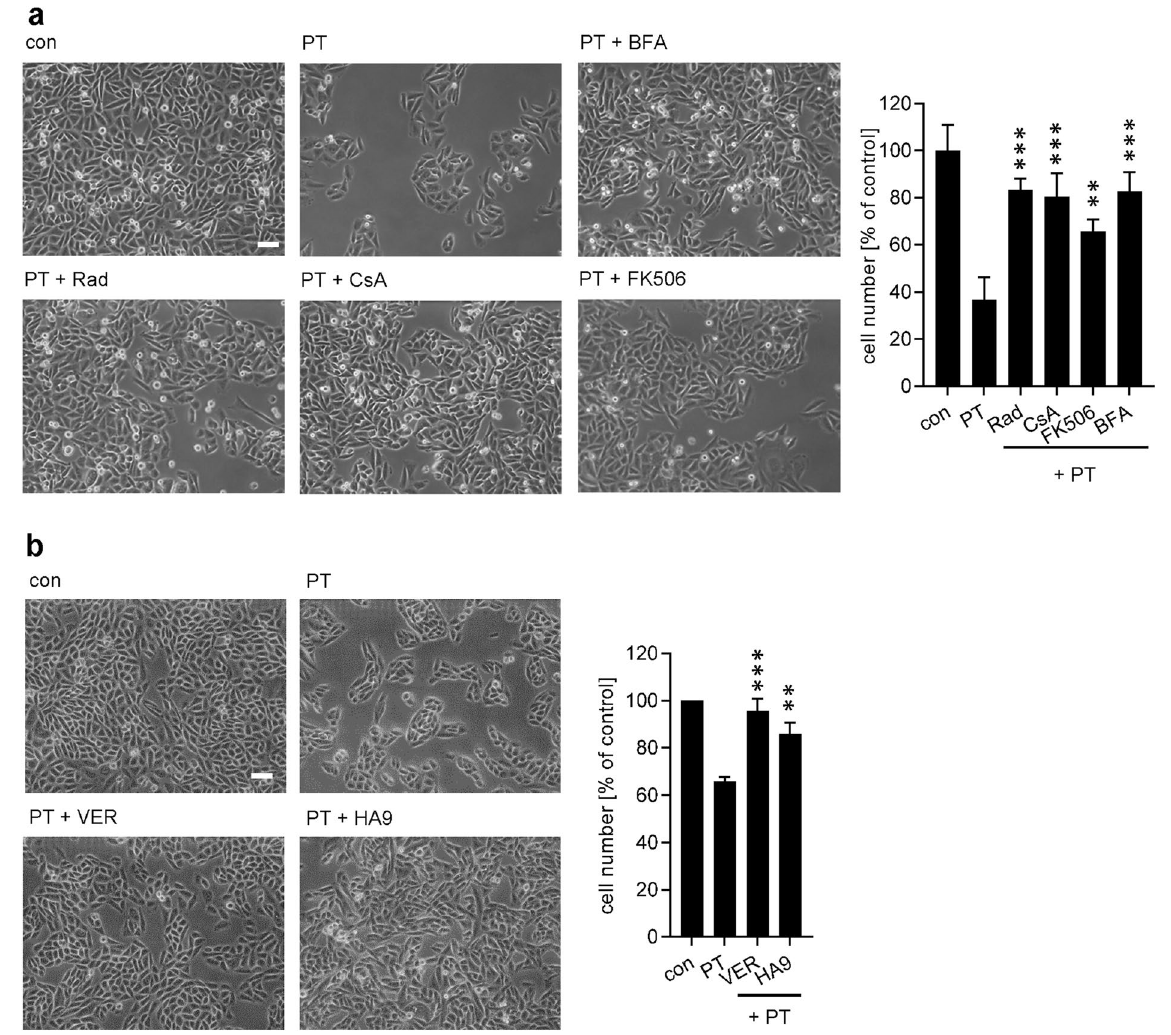
Figure 1. ( a ) Effect of BFA, Rad, FK506 and CsA on the intoxication of CHO-K1 cells with PT. CHO-K1 cells were pre-incubated with 10 µM BFA, Rad, FK506 or CsA or left untreated for control. After 30 min 10 ng/ml PT were added. 1.5 h later the culture medium was removed, and cells were further incubated at 37 °C and 5% CO 2 in fresh medium that did not contain PT or any inhibitor. Pictures were taken after 18 h. A quantitative analysis of total cell number of CHO-K1 cells is shown, values are normalized on control cells (n = 3, mean ± SD). ( b ) Pharmacological inhibition of Hsp70 activity protects cells from PT-intoxication. CHO-K1 cells were treated with VER (30 μM) or HA9 (20 µM) for 30 min and then intoxicated with PT (10 ng/ml) for 18 h. Pictures were taken, and cell numbers were determined as described in A. Significance was tested by one-way ANOVA with Dunnett’s multiple comparisons test and refers to samples treated with PT only (*p < 0.05, **p < 0.01, ***p < 0.001). Scale bar = 50